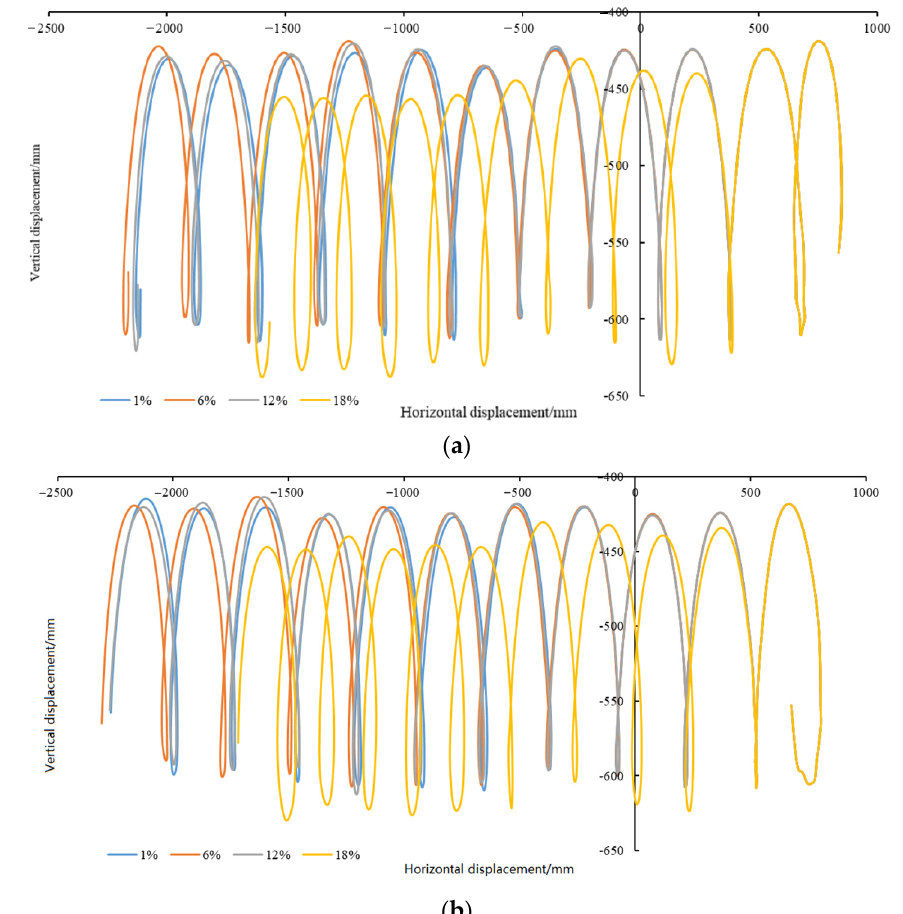
Figure 9. Trajectory of cavity seeder’s movement under sandy soil. ( a ) Right cavity seeder. ( b ) Left cavity seeder.